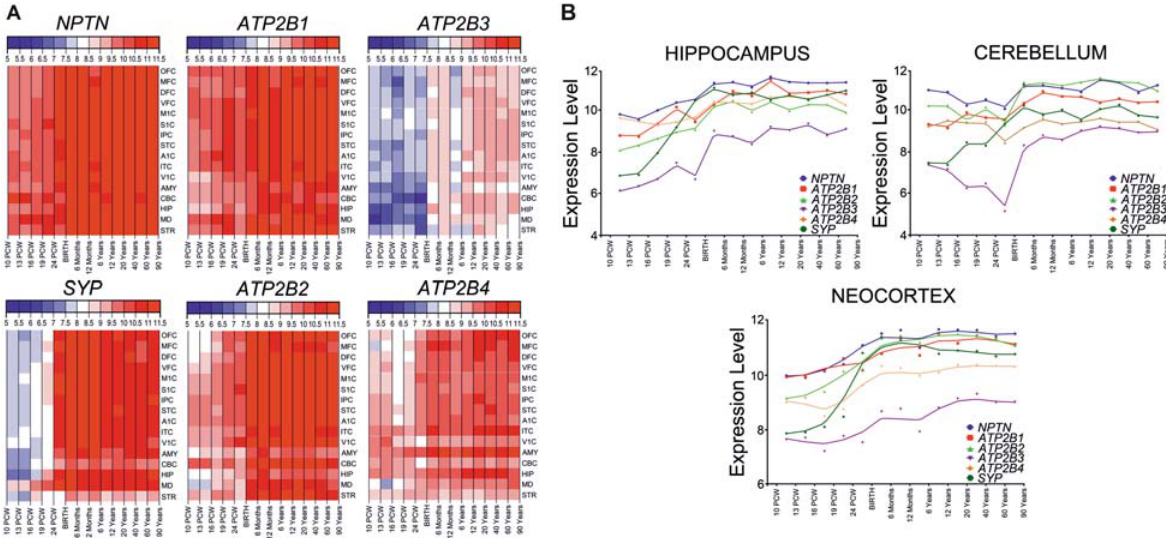
Fig. 2 Spatio-temporal gene expression of neuroplastin, plasma membrane calcium ATPase and synaptophysin in human brain. A Spatio- temporal transcriptome of neuroplastin, plasma membrane calcium ATPase isoforms 1 – 4, and synaptophysin in the human brain as extrapolated from refs. [7, 58]. Heatmaps depict gene expression values (color code key at the top of heatmap), in different brain areas and developmental periods. B Comparison of gene expression values for neuroplastin, plasma membrane calcium ATPase isoforms and synaptophysin in the human neocortex, hippocampus, and cerebellum during development, adulthood, and aging. Developmental periods are shown on the x -axis and level of expression on the y -axis. A1C, primary auditory (A1) cortex; AMY, amygdala; ATPB2[1 – 4] , plasma membrane calcium ATPase isoforms 1 – 4; CBC, cerebellar cortex; DFC, dorsolateral prefrontal cortex; HIP, hippocampus; IPC, posterior inferior parietal cortex; ITC, inferior temporal cortex; M1C, primary motor (M1) cortex; MD, mediodorsal nucleus of the thalamus; MFC, medial prefrontal cortex; NPTN , neuroplastin; OFC, orbital prefrontal cortex; S1C, primary somatosensory (S1) cortex; STC, superior temporal cortex; STR, striatum; SYP , synaptophysin; V1C, primary visual (V1) cortex; VFC, ventrolateral prefrontal